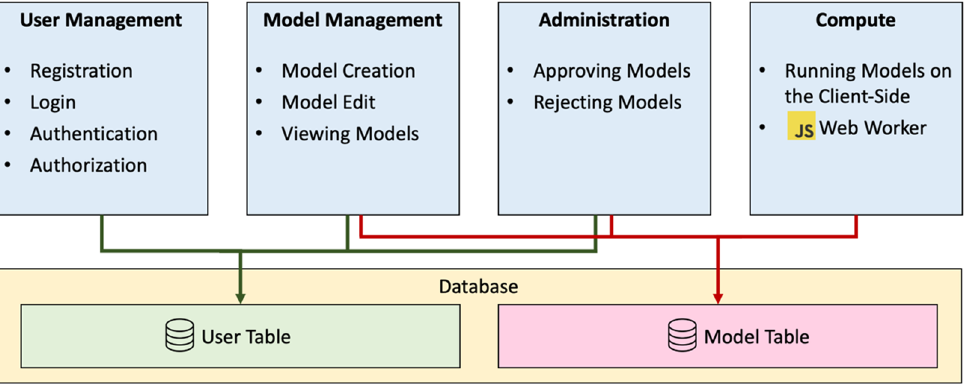
Figure 3. Modules and their connections over different tasks on EarthAIHub.